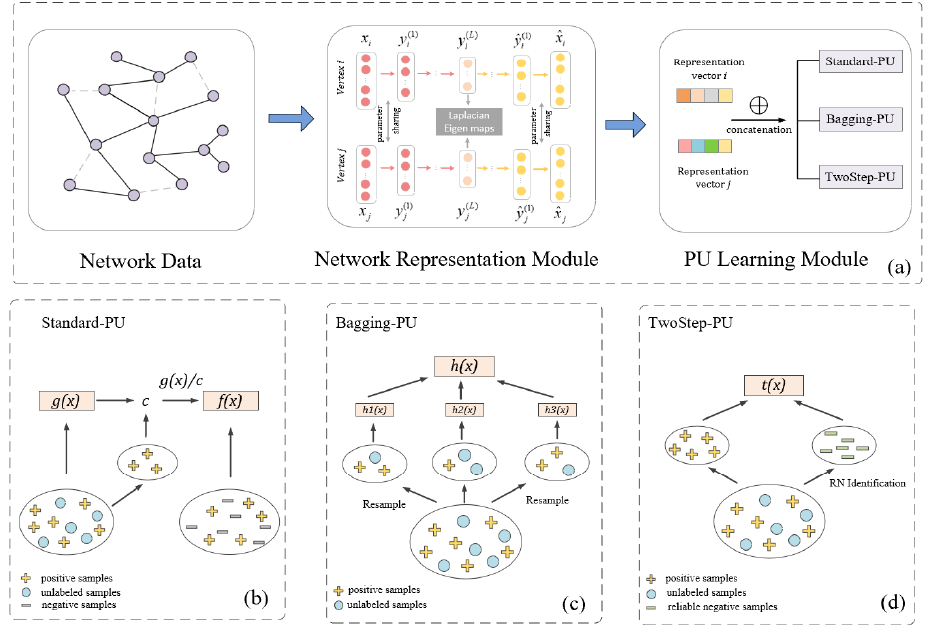
Figure 2. The architecture of our proposed framework consists of two modules: network represen- tation module and positive-unlabeled learning module, as shown in Figure 2a. The positive-unla- beled learning module adopts three strategies to enhance the performance of predictive model (tra- ditional classifier estimation is shown in Figure 2b, bagging strategy is shown in Figure 2c and reli- able negative sampling is shown in Figure 2d).